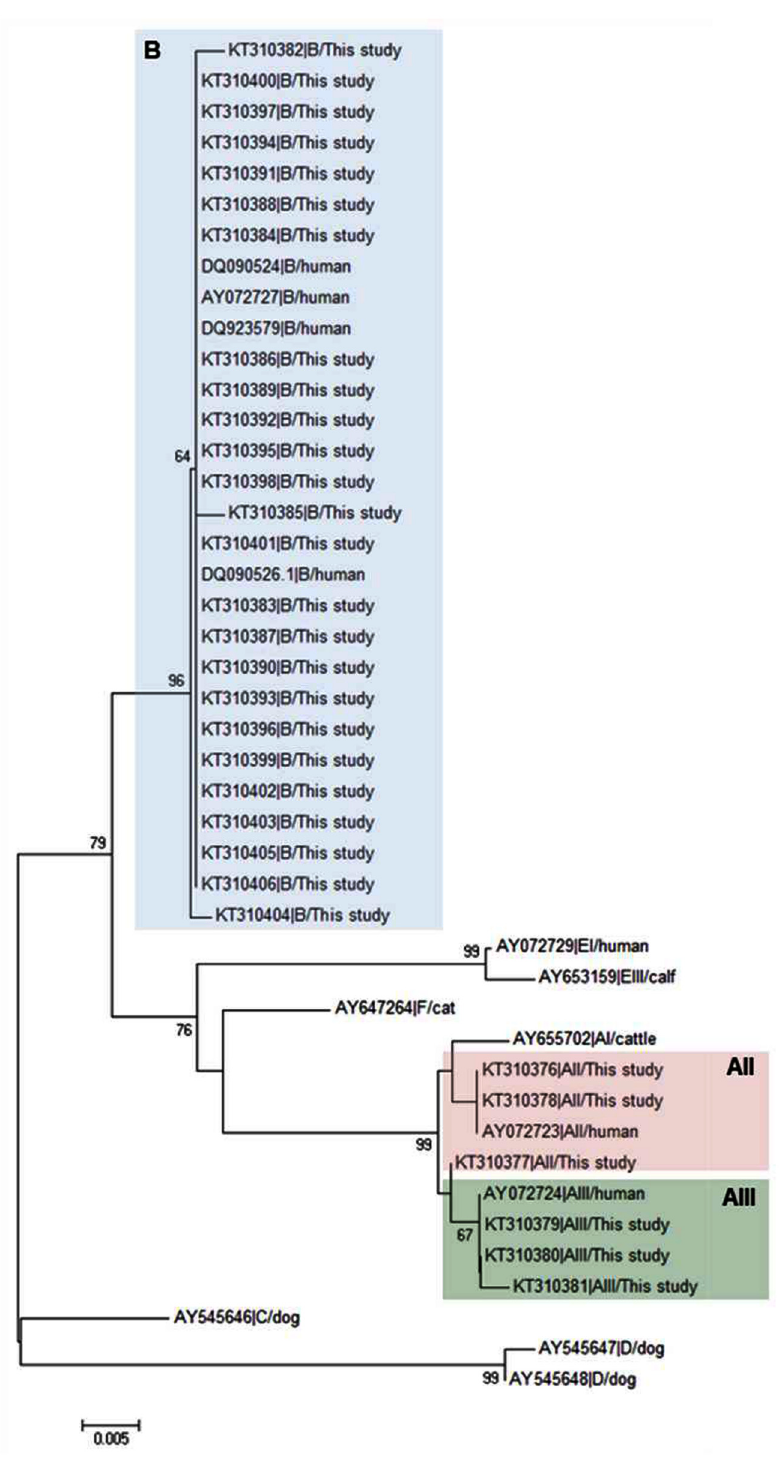
Fig 2. Evolutionary relationships among assemblages of G . duodenalis at the BG locus inferred by a neighbour-joining analysis of the nucleotide sequence covering a 458-bp region (positions 116 to 573 of GenBank accession number AY072727) of the gene. GenBank accession numbers are provided for each sequence used. The bootstrap consensus tree was inferred from 1,000 replicates. Branches corresponding to partitions that were reproduced in less than 50% of bootstrap replicates are collapsed.